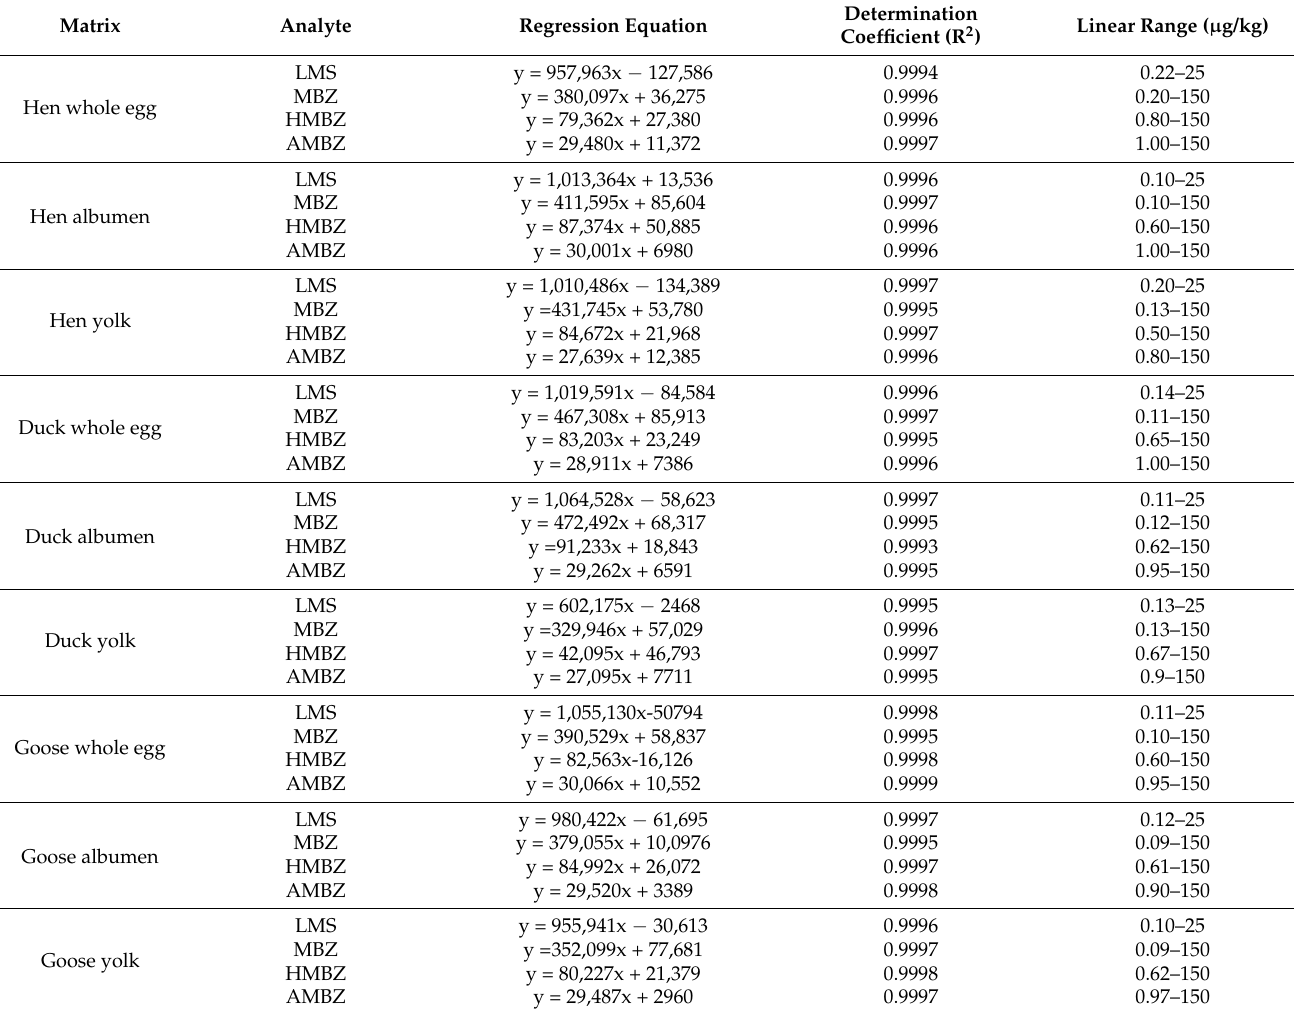
Table 4. Linear regression equations, determination coefficients, and linear ranges for LMS, MBZ, HMBZ, and AMBZ in poultry